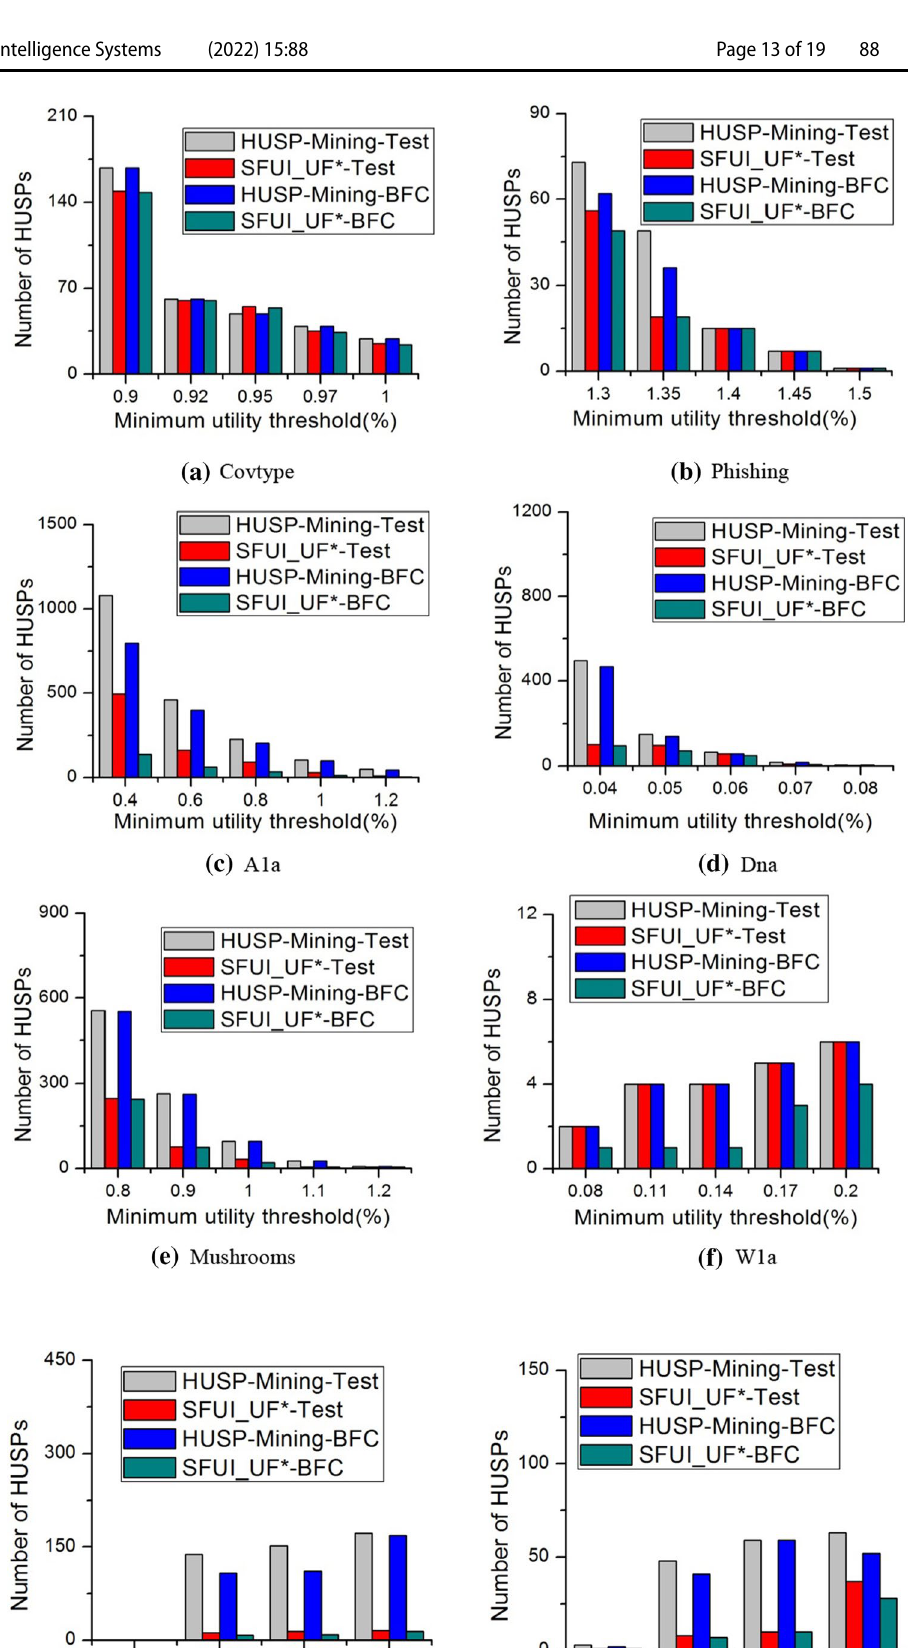
Fig. 9 Number comparisons of HUSPs